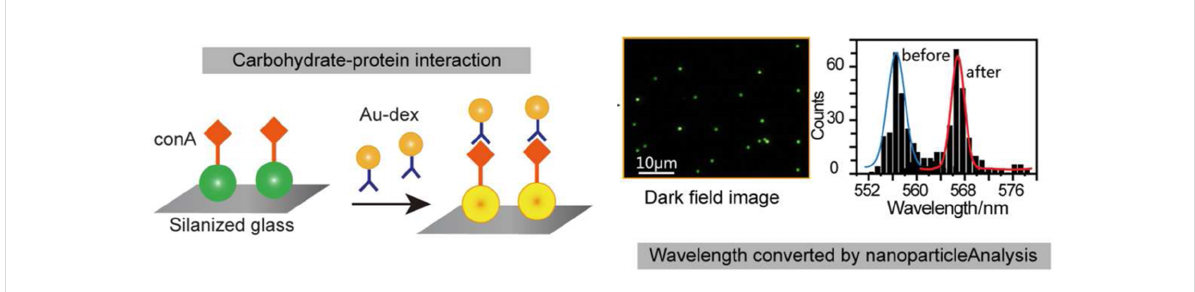
Figure 3: The protein–carbohydrate interactions analyzed by conventional dark field microscopy. The interaction among ConA-functionalized AuNPs (60 nm) and dextran-coated AuNPs (20 nm) are detected by DFM. Reprinted with permission from [50]. Copyright 2015 American Chemical Society.